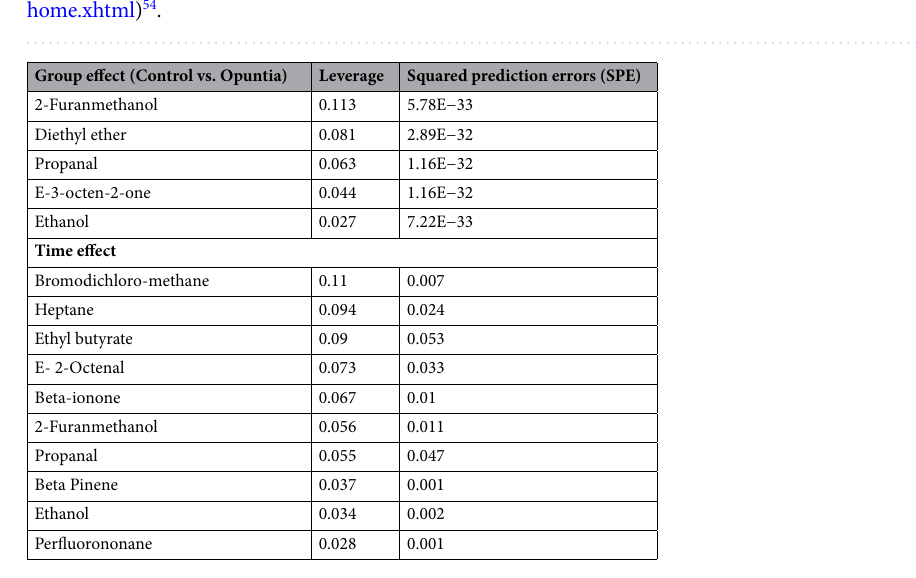
Table 3. Important features that are well modelled by the ANOVA-simultaneous component analysis (ASCA) variables sub-models for Control and Opuntia sheep, and time.